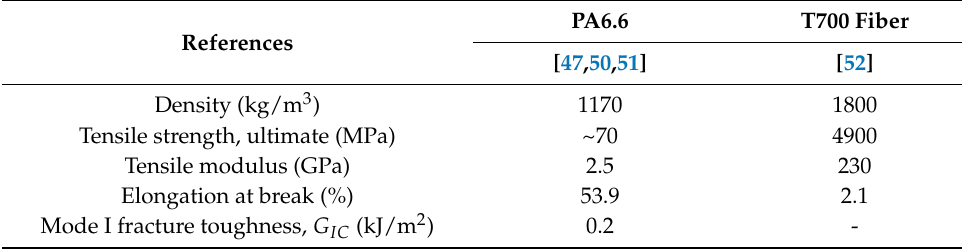
Table 1. Mechanical properties of neat PA6.6 and T700 fiber.